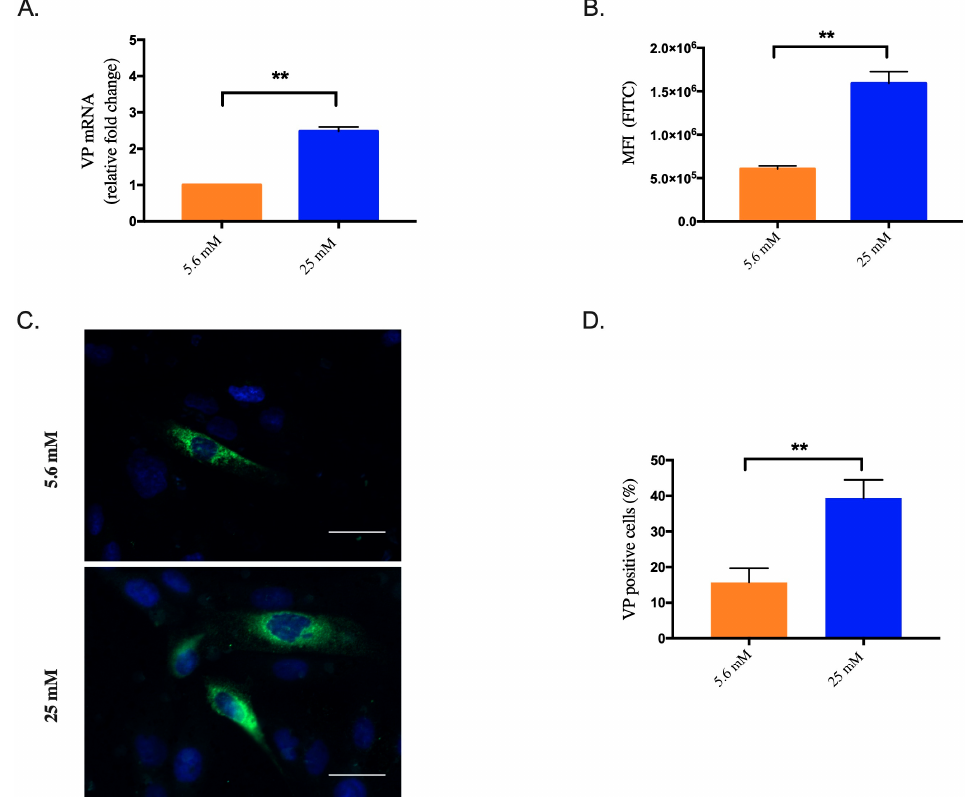
Figure 1. High glucose concentration induces endogenous viperin overexpression in HK-2 cells. ( A ) Viperin (VP) mRNA expression in HK-2 NGC cells (5.6mM) or HK-2 HGC cells (25mM) was de- tected using quantitative polymerase chain reaction. ( B ) Detection of endogenous viperin protein by flow cytometry. ( C ) Viperin protein detected by immunofluorescence staining in HK-2 cells. ( D ) Quantitative analysis of VP immunofluorescence by ImageJ software. Viperin (green) and nuclei (blue) were visualized by confocal fluorescence microscopy. Results are shown as means ± SD of three independent experiments. Unpaired t-test shows that differences are statistically significant (** p < 0.01). Scale bar represents 40 µ